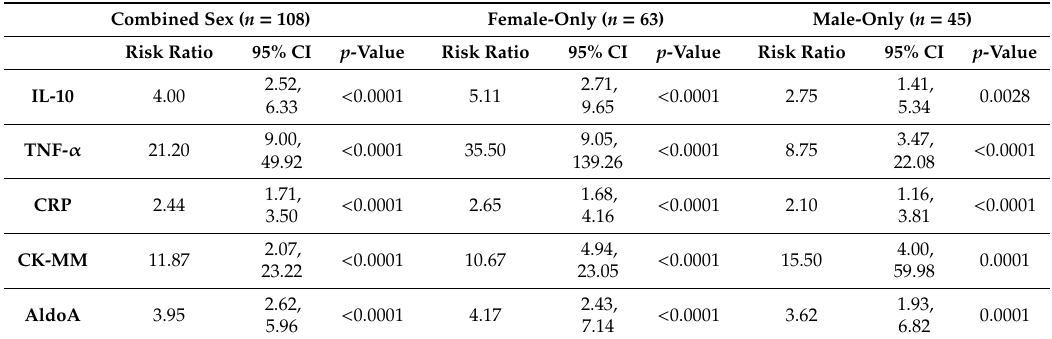
Table 4. Analysis of risk ratios of biochemical parameters for combined-sex, female-only, and male-only.